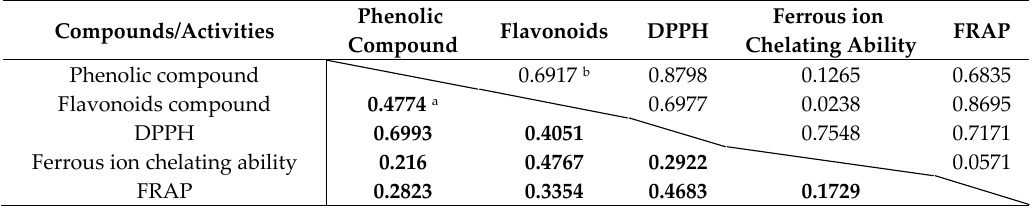
Cancers 2016 , 8 , 33 Table 4. Correlation R 2 values between the chemical compound and antioxidant activities of Chinese fruits. Compounds/Activities